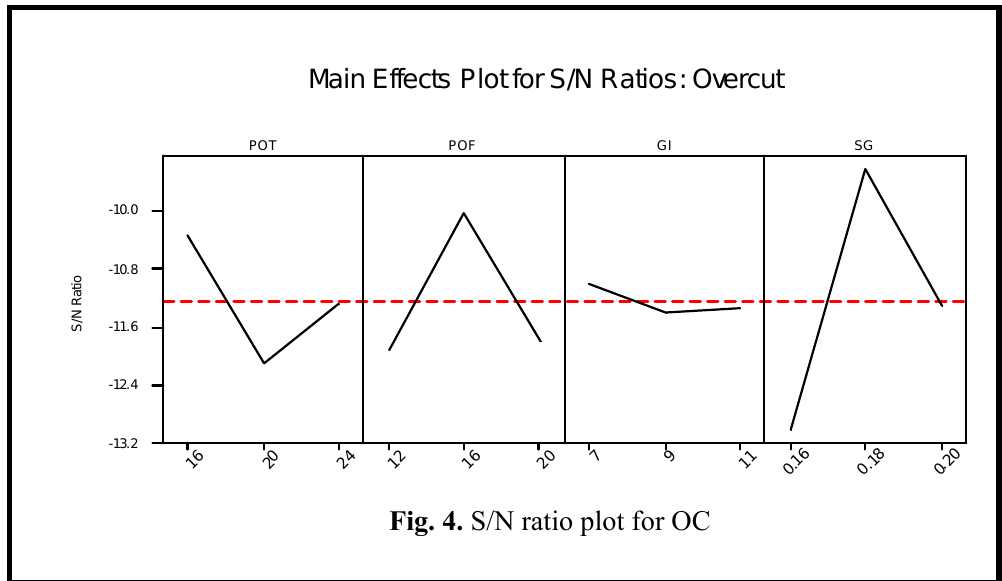
Fig. 4. S/N ratio plot for